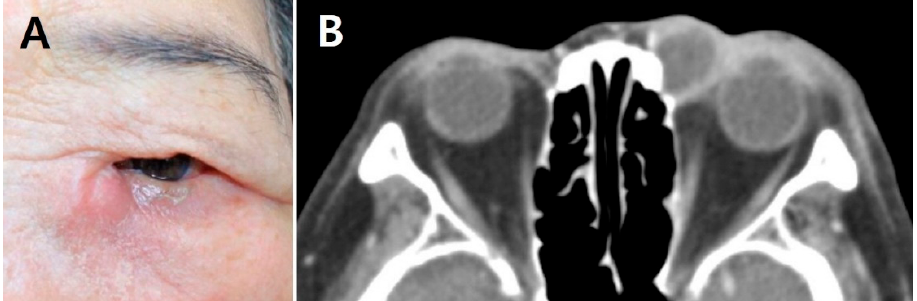
Figure 1. Representative facial photograph and computed tomography (CT) imaging of an AD patient. ( A ) External photograph of an 80-year-old woman who presented with pain, redness, and swelling around left the lacrimal sac area. ( B ) CT scan showing peripheral enhancing cystic lesion in the left medial canthal area with enhancing soft tissue swelling in the adjacent periorbital area.